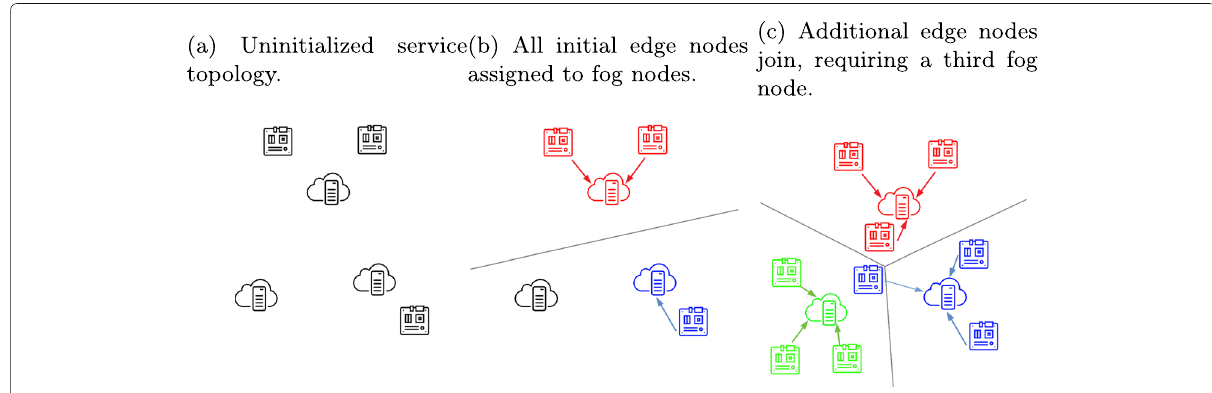
Fig. 1 Different stages of building a service topology with Swirly